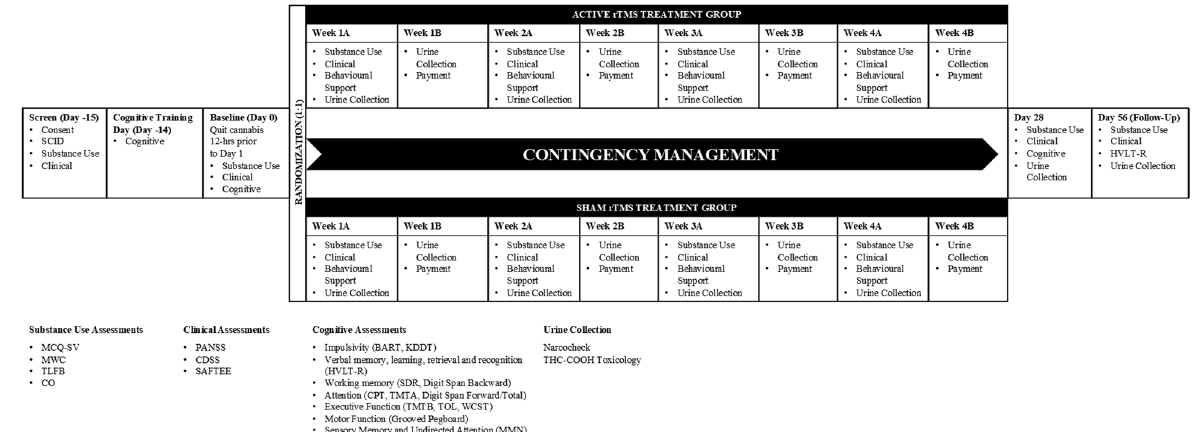
Fig. 5 Study timeline and assessment schedule. Participants found eligible after an in-person screen, completed Cognitive Training Day (exclusive of MMN), followed by a 2-week lead-in phase including a Baseline (Day 0) in which a cognitive battery, MMN, and clinical and substance use outcomes were assessed. They were then randomized into either active or sham rTMS treatment, Monday to Friday over 4 consecutive weeks, during which assessments were completed to monitor clinical symptoms and substance use. Behavioral support was also provided at these sessions. Contingency management was used to reinforce participants ’ attendance. The same battery of assessments as on Baseline was then completed on Day 28 (post session). A brief session was also completed on Day 56 (Follow-Up session). CDSS,